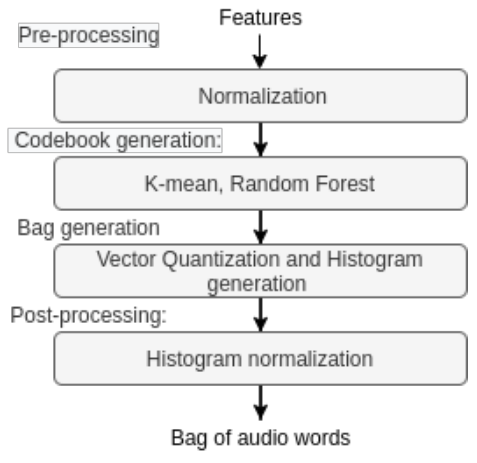
Figure 2. Steps for bag of audio word